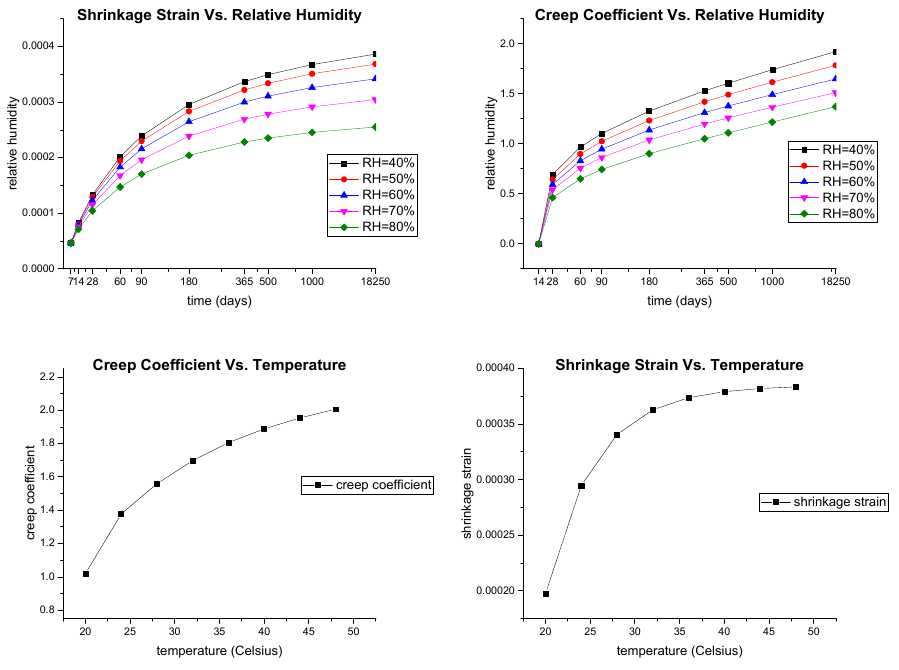
Figure 1. The effect of extreme climate on long-term performance of prestressed concrete